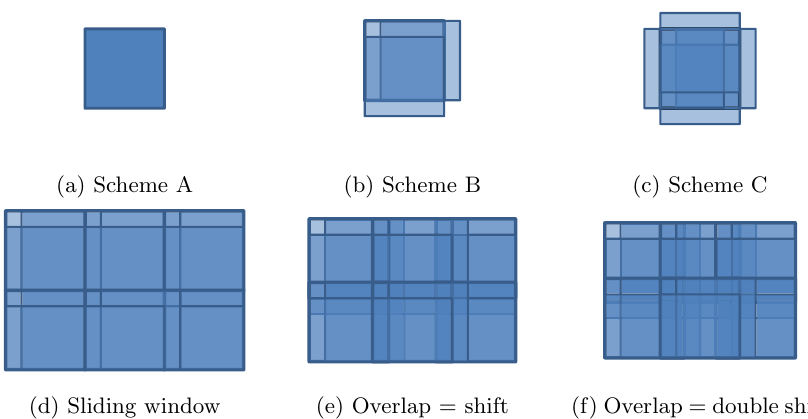
Figure 2. Comparison of three schemes for an overlapped patch extraction (top row). An example of overlap achieved with different stride of sliding window algorithm with Scheme B (bottom row). In ( e ) the example is presented where the stride is balanced so that overlap is equal to the size of the shift in Scheme B. Original ROI (without additional ones) highlighted with thicker lines in every example. More overlapping ROI are denoted with color-darker with more overlapping